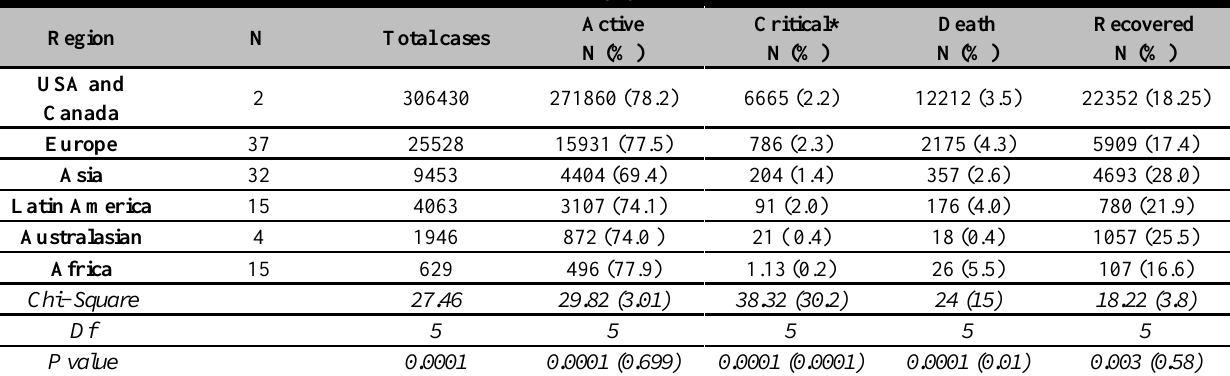
Table 8. COVID-19 disease outcome and the distribution of ABO blood groups in 6 geographical regions on the13 th of